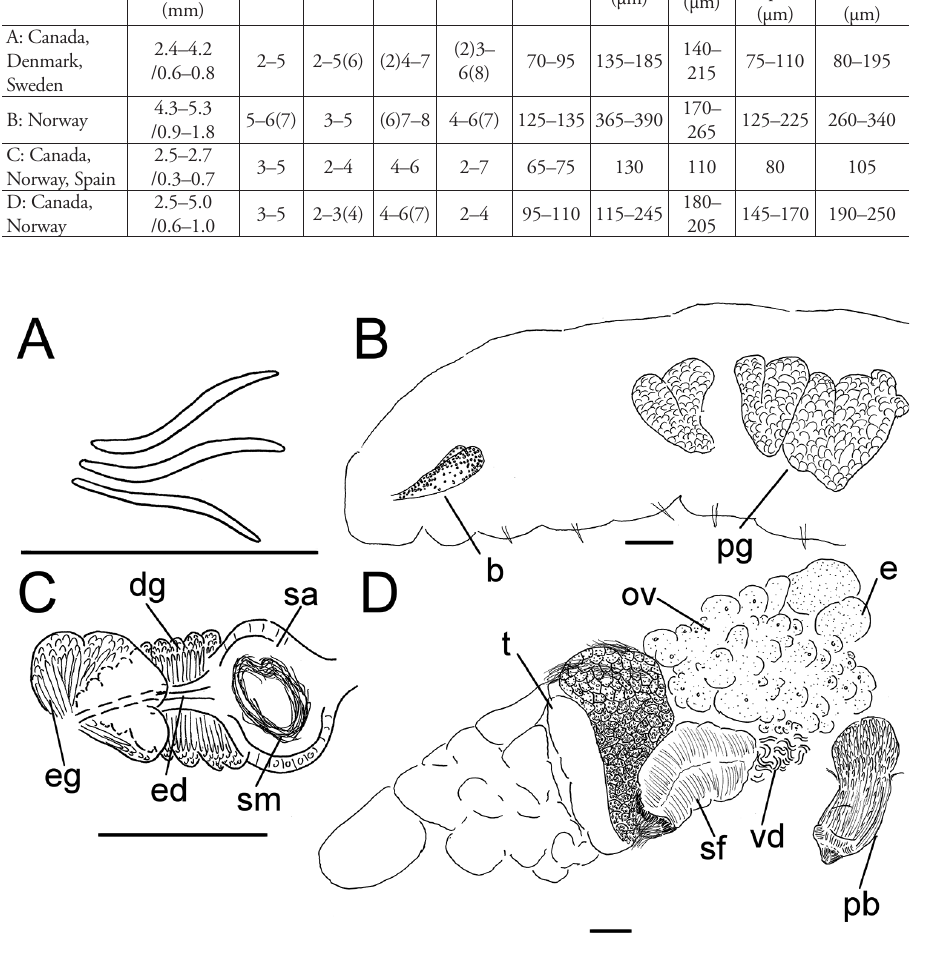
Figure 14. Lumbricillus pagenstecheri A. A Chaetal bundle B Anterior body C Spermatheca D Other genitalia. Abbreviations under general notes. Scale bars: 100 µm.